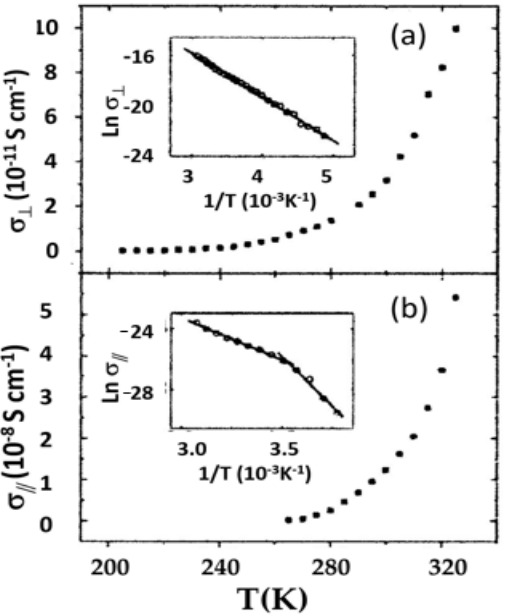
Figure 14. Electrical conductivity in a triclinic porphyrin single crystal (after Ref. [27], with permission from Taylor and Francis): ( a ) conductivity perpendicular to the a -axis; and ( b ) parallel with the a -axis.